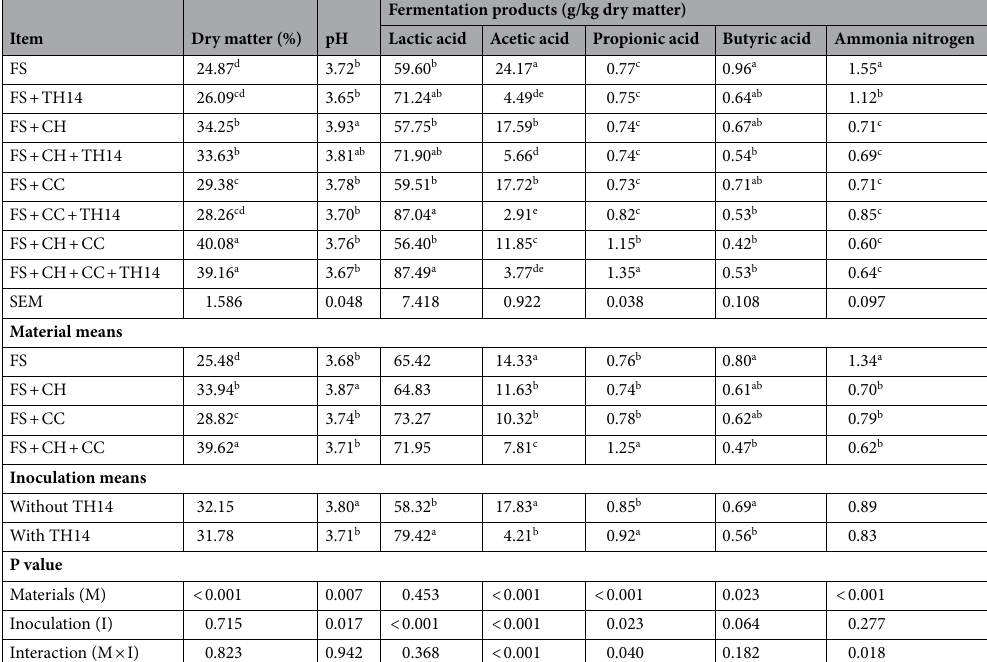
Table 2. Fermentation characteristics of the FS mixture silages. FS forage sorghum, CH Cavalcade hay, CC cassava chip, TH14 L. casei TH14 inoculant, SEM standard error of the means. Means within columns with difference superscript letters differ at p < 0.05.